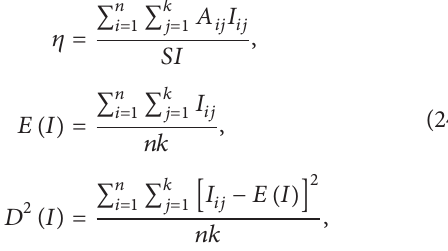
Figure 4: The irradiance distribution of absorbing surface at different aperture width.